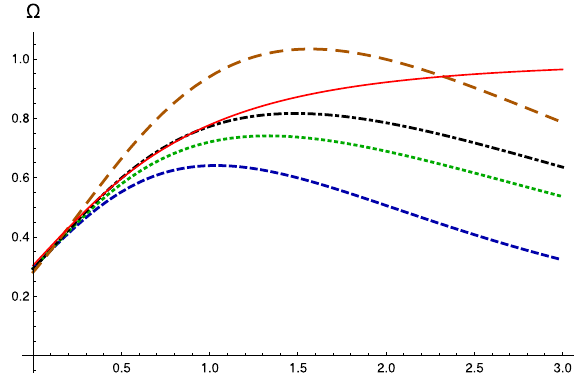
Fig. 3 Theevolutionofthedustmatterdensityabundanceasafunction of redshift z for β = 0 . 001 (dashed), 0 . 05 (dotted), 0 . 1 (dot-dashed) and 0 . 5 (long dashed). The red solid line represents the evolution of the conservative matter